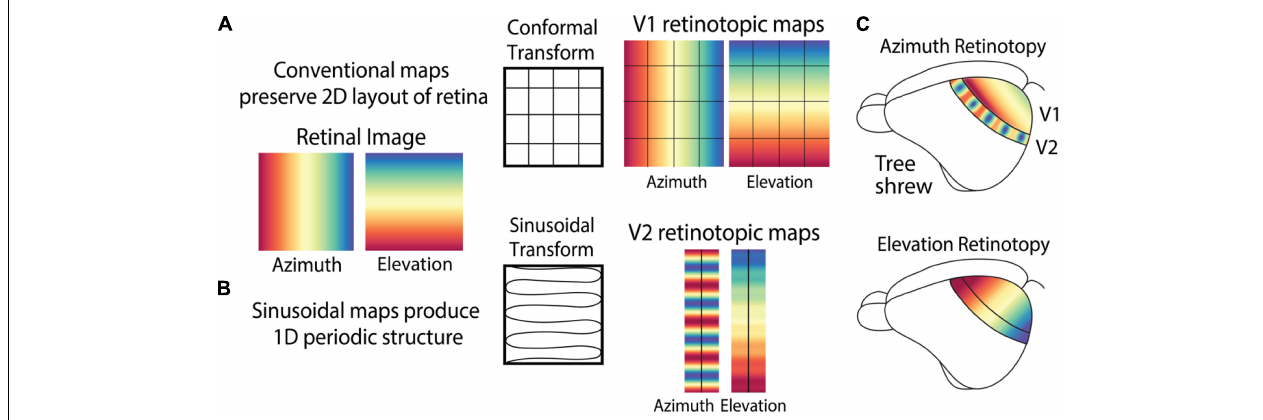
FIGURE 3 | Retinotopic maps in the cortex can exhibit complex patterns that do not maintain the topographic layout of the retina. (A) Maps of retinotopic spatial location in V1 of most animals, including tree shrews, exhibits a conformal transform that preserves 2D layout of the retina including the orthogonal relationship between azimuth and elevation. (B) V2 of tree shrews exhibits a sinusoidal retinotopic transform that combines azimuth and elevation to produce a periodic structure. (C) Azimuth and elevation retinotopic maps in tree shrew V1 and